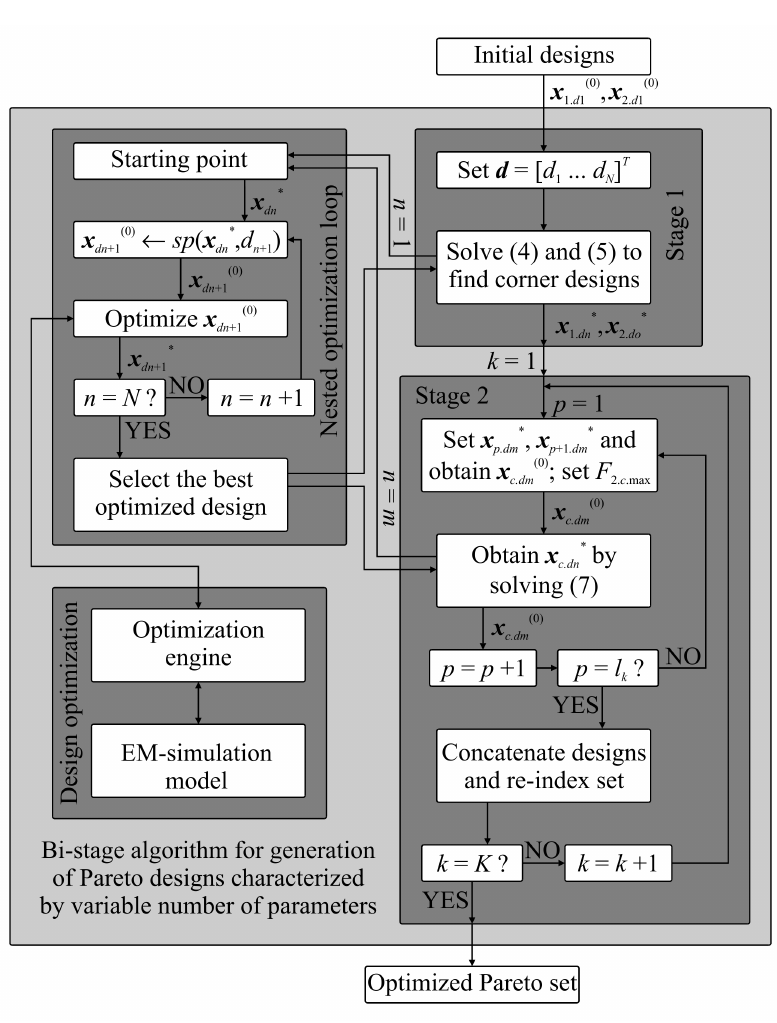
Figure 4. Block diagram of the proposed bi-objective optimization